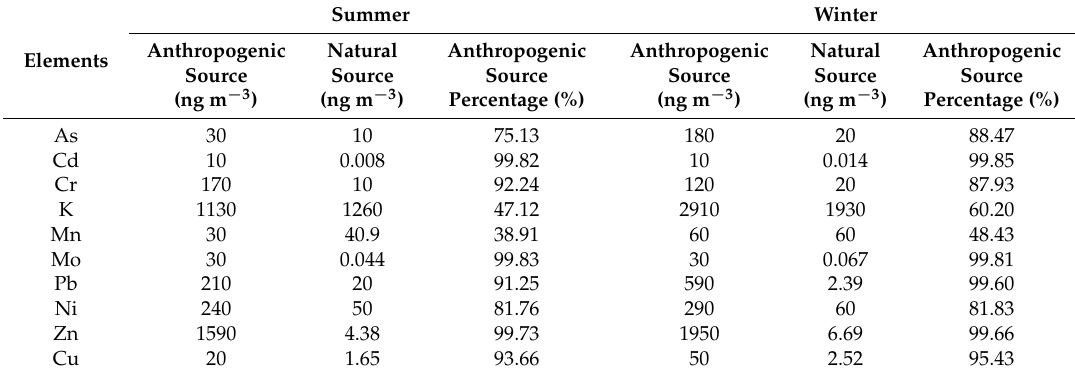
Table 2. The relative contributions of natural and anthropogenic sources to elements found in PM 2.5 .